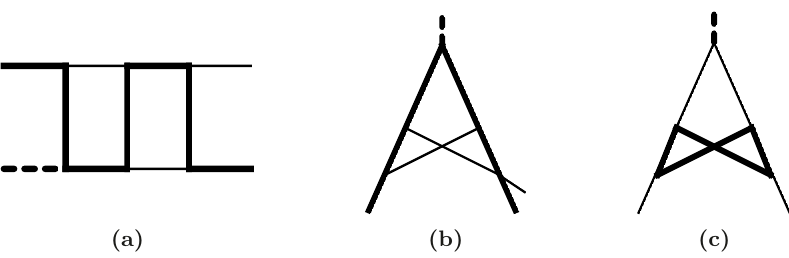
Figure 5. Diagrams defining the topologies for the differential equations used in the numerical evaluation of the integrals involving eMPLs. The thick dashed line has mass λ 2 , while the solid thick lines have mass m 2 . Thin lines are Q